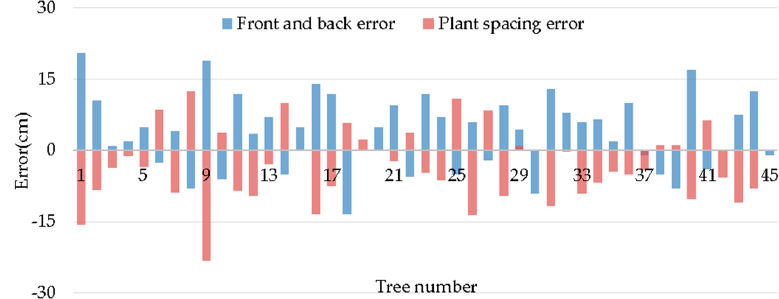
Figure 18. Comparisons of the front and back error and the plant spacing error.